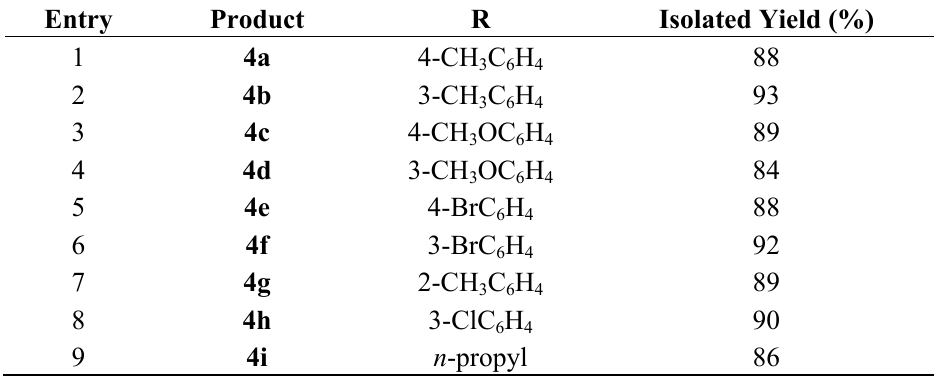
Table 1. The synthesis of pyrazolo[3,4- b ]pyridine-6(7 H )-one derivatives in aqueous